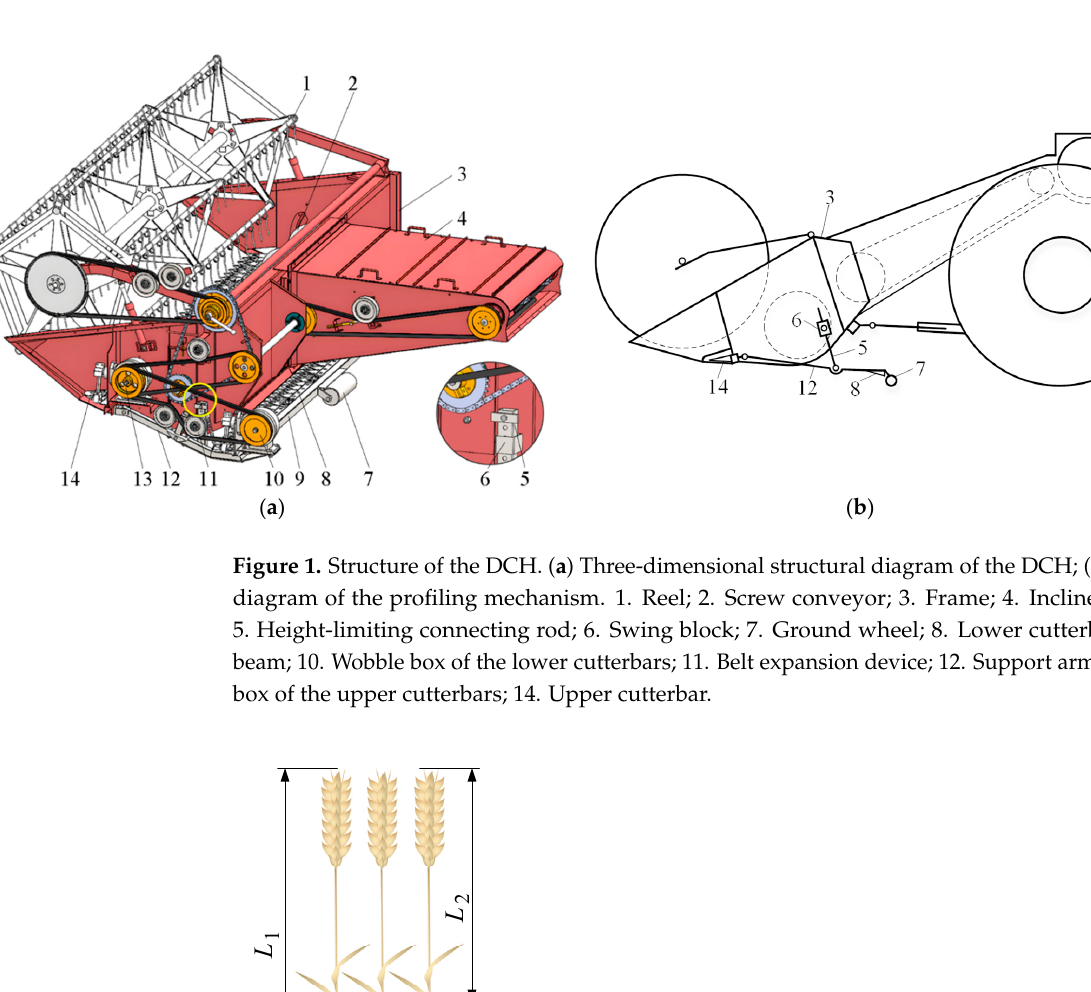
Figure 1. Structure of the DCH. ( a ) Three-dimensional structural diagram of the DCH; ( b ) Structural diagram of the profiling mechanism. 1. Reel; 2. Screw conveyor; 3. Frame; 4. Inclined conveyor; 5. Height-limiting connecting rod; 6. Swing block; 7. Ground wheel; 8. Lower cutterbar; 9. Fixed beam; 10. Wobble box of the lower cutterbars; 11. Belt expansion device; 12. Support arm; 13. Wobble box of the upper cutterbars; 14. Upper cutterbar.